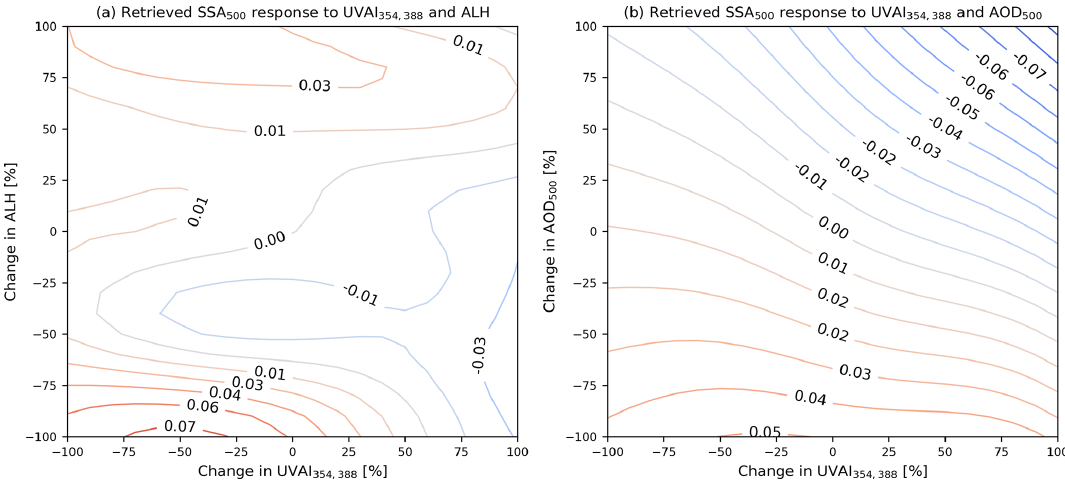
Figure 9. The sensitivity of the SVR-retrieved SSA: (a) the response of predicted SSA at 500nm as a function of changes in UVAI and ALH; (b) the response of predicted SSA at 500nm as a function of changes in UVAI and